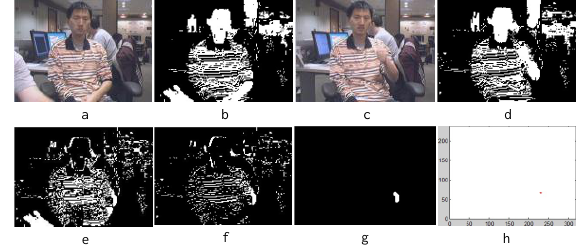
Figure 7. Problem of skin-liked shirt